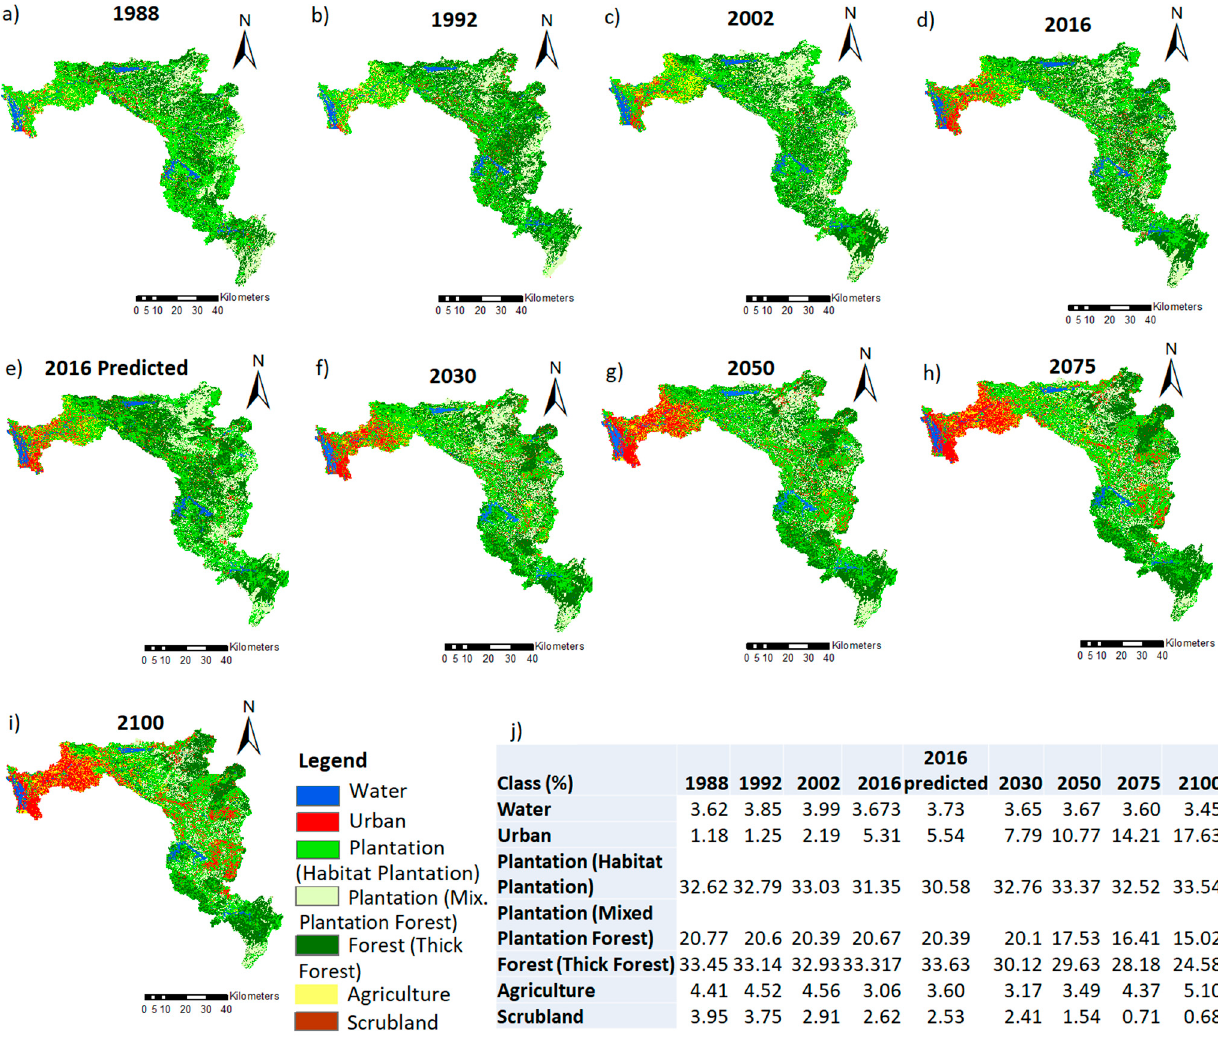
Figure 2. Classified: ( a ) 1988, ( b ) 1992, ( c ) 2002, ( d ) 2016; projected: ( e ) 2016, ( f ) 2030, ( g ) 2050, ( h ) 2075; ( i ) 2100 LULC maps for PRW; ( j ) percentage change in LULC classes (1988–2100).